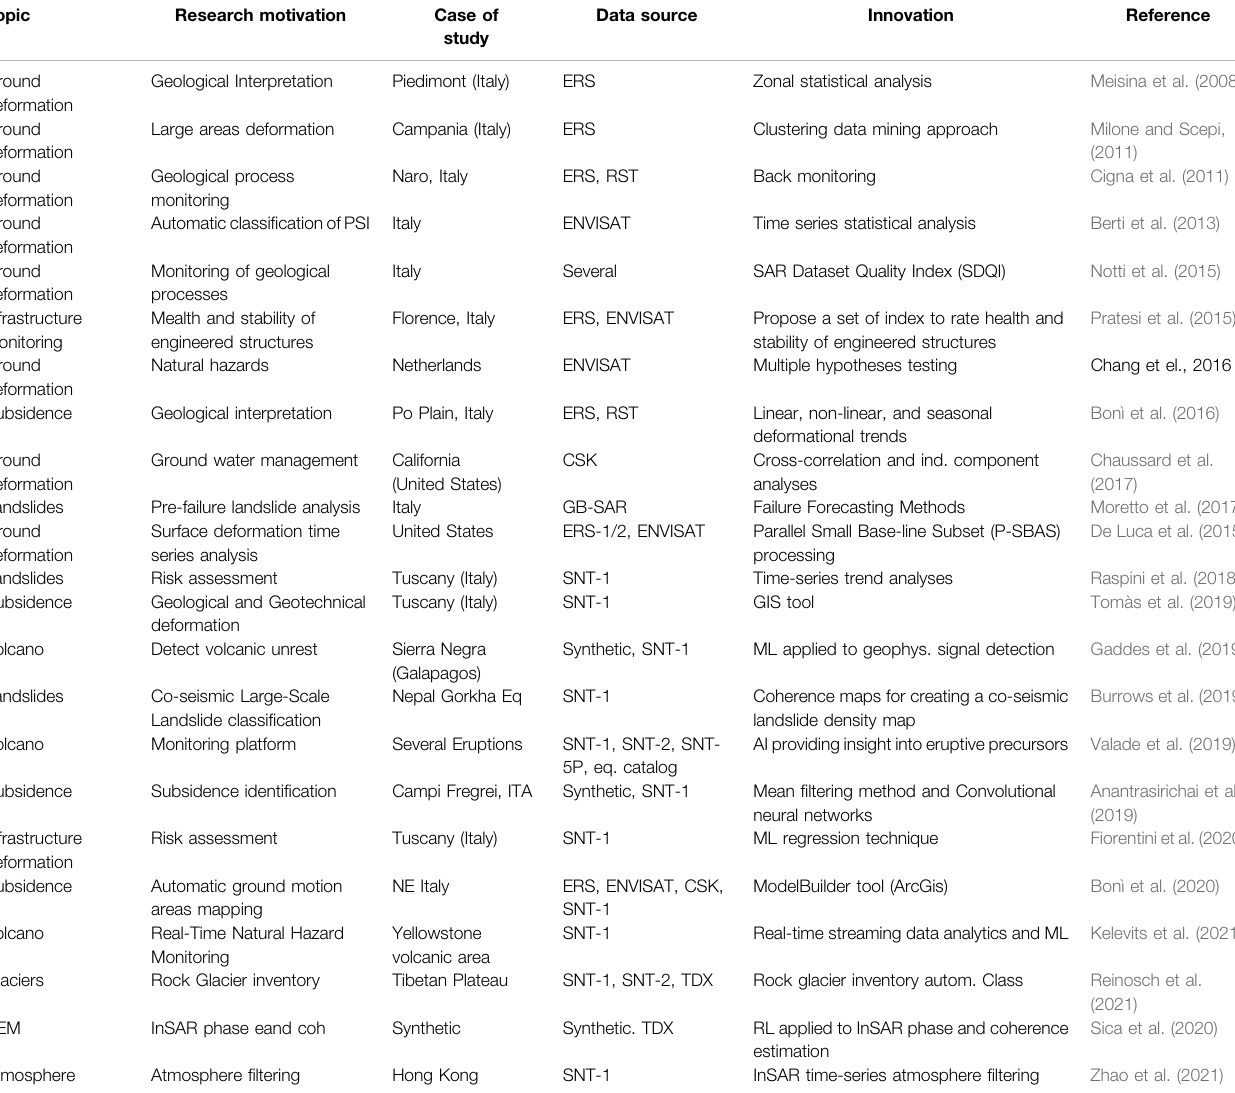
TABLE 1 | Revised literature of the main classi fi cation approaches applied to